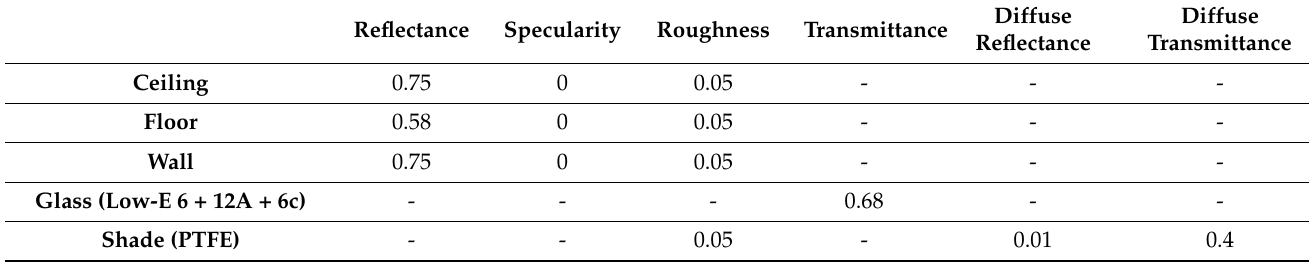
Table 4. Parameter values for simulated rooms and shading objects (self-developed).